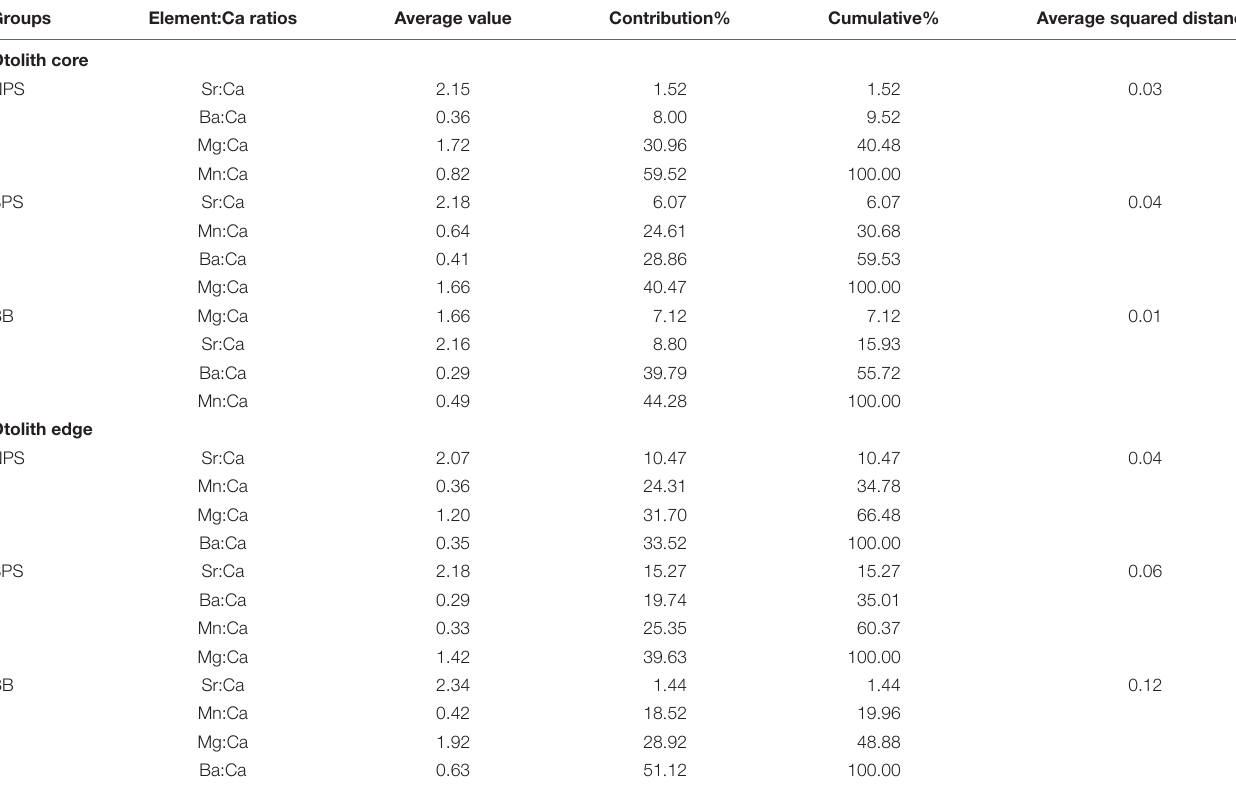
TABLE 4 | SIMPER analyses for the three groups of C. trigloides individuals identifying the most relevant element:Ca ratios responsible for the grouping for the core and edge areas of the otolith. Groups